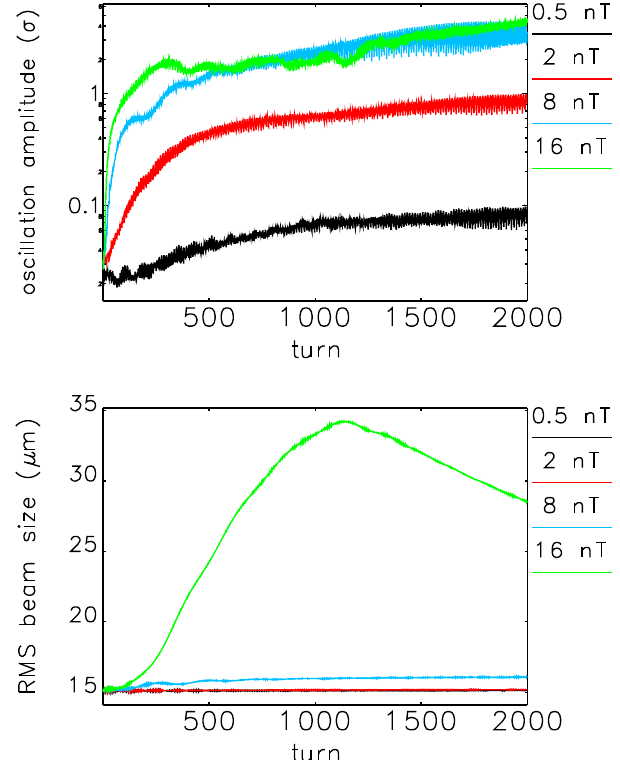
FIG. 12. Vertical instability amplitude (top) and rms beam size (bottom), for different pressure